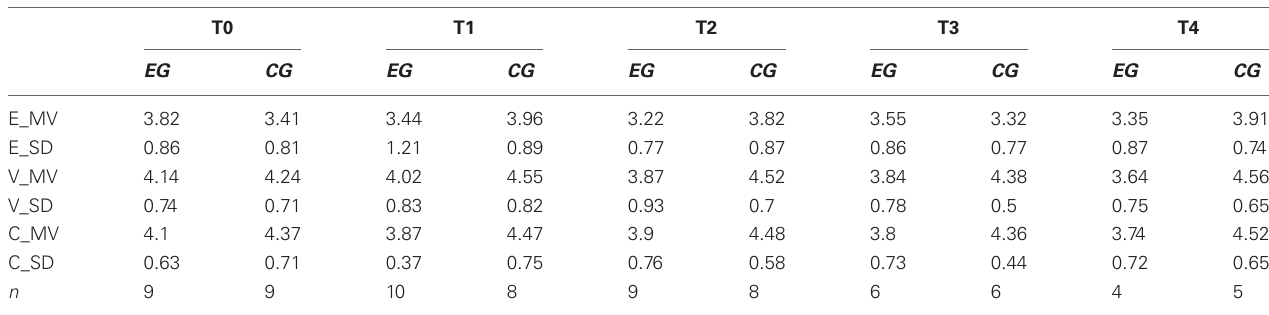
Table 4 | Mean scale values of the mood dimensions E , V , C at T0–T4, respectively for EG and CG